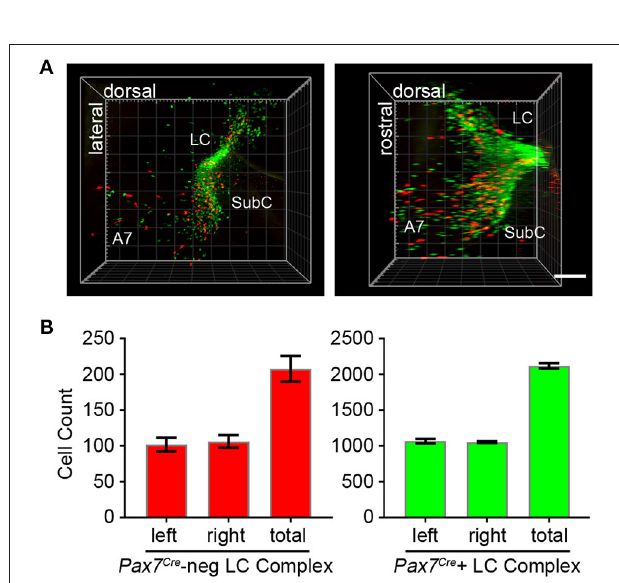
FIGURE 4 | Quantification of Pax7 Cre -negative and Pax7 Cre -positive noradrenergic neurons in the LC complex. (A) Left LC complex from the brain of an adult En1 Dre ; Dbh Flpo ; Pax7 Cre ; RC::RFLTG quadruple heterozygote cleared via the passive clarity technique (PACT) shows the spatial relationship of the r0- and r1-derived LC, SubC, and A7 nuclei. Immunolabeling of the intact tissue permits counting of Pax7 Cre -negative (red) and Pax7 Cre -positive (green) noradrenergic neurons throughout the LC complex. Left, view from anterior surface; Right panel, view from medial surface; scale bar, 300 µ m. See also Supplementary Video 1 . (B) Bilateral cell counts of Pax7 Cre -negative and Pax7 Cre -positive LC complex noradrenergic neurons from PACT-cleared brains of 4 to 5-month old